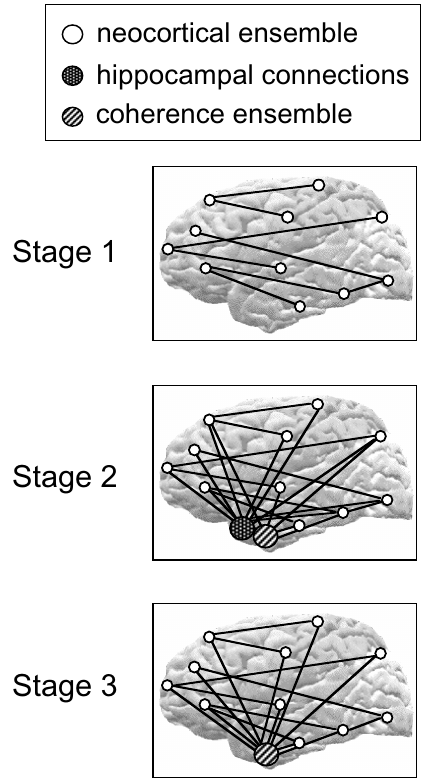
Fig. 3. Figurative depiction of the stages of consolidation of dis- persed neocortical memories. In stage 1, a fact or event is encoded via representations that involve multiple cortical regions, based on working memory processes controlled by prefrontal cortex. At about the same time, this dispersed representation begins to make contact with neurons in the medial temporal region. Hippocampal connec- tions rapidly become part of a newly formed network so that the dispersed cortical fragments can remain connected beyond the span of immediate memory. In stage 2, coherence ensembles are formed in entorhinal, perirhinal, and parahippcampal cortex, and in adjacent cortical regions, and these become part of the network. Connections become strengthened as the memory is reactivated on subsequent occasions, while coherence ensembles develop a central role as they take on gestalt-like aspects of the memory and its relationship to other memories. Coherence ensembles thus function to maintain co- hesiveness among the various parts of the declarative memory. In stage 3, coherence ensembles take part in the reactivation of the dis- persed neocortical memory without any necessary contribution from hippocampal connections.